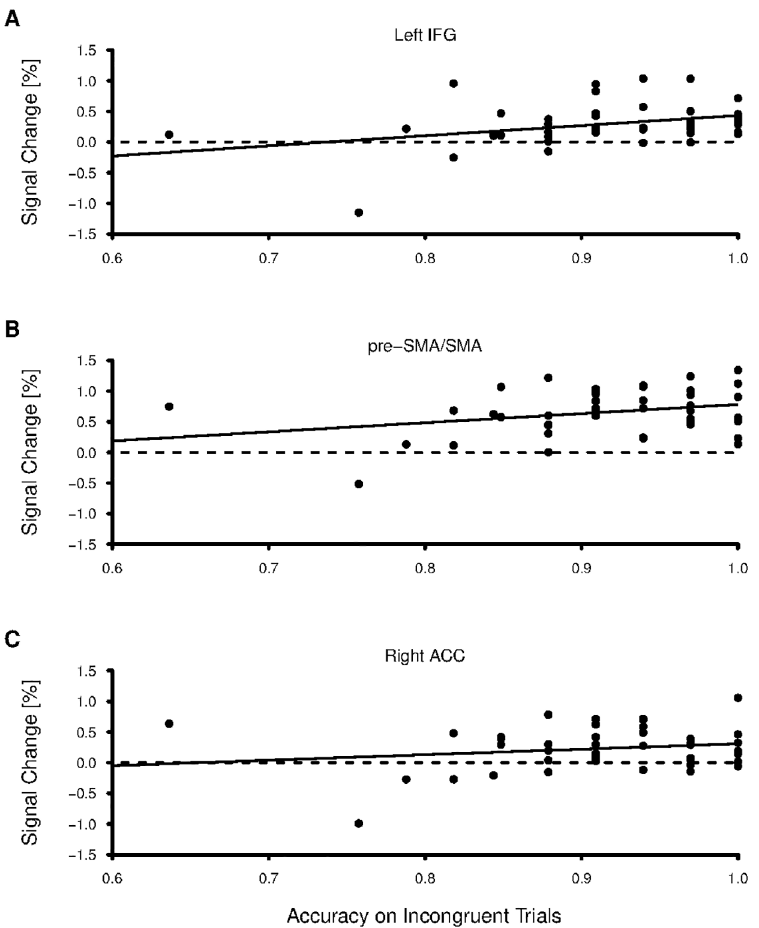
Fig 7. Linear regression plots between accuracyon incongruent trials of the behavioral Color-Word Stroop task and percent signal change in the (A) left IFG, (B) pre-SMA/SMA, and (C) right ACC for the incongruent > congruent contrast during the fMRI Color-Word Stroop task. No correlations were significantafter correction for multiple comparisons.